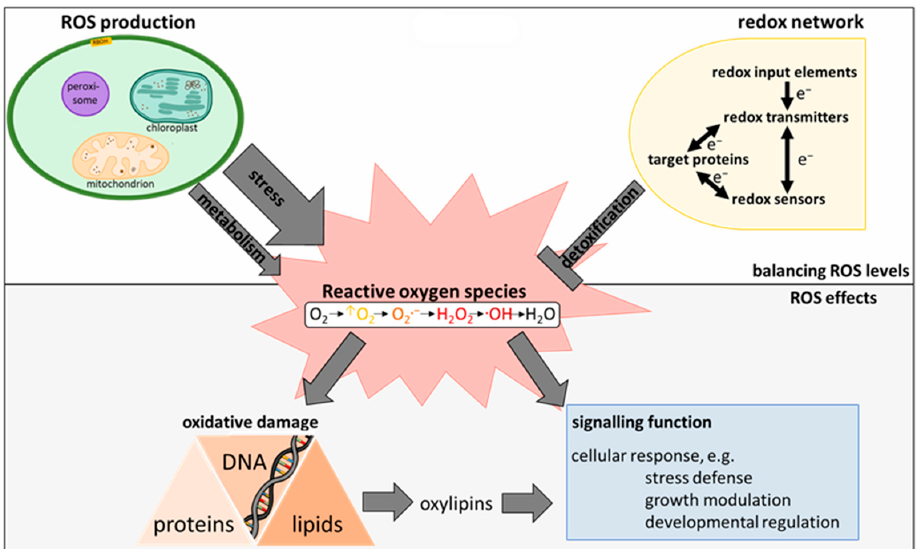
Figure 1 . Regulation of ROS levels and their effect on plant cells. ROS are generated in cytosol, apoplast, plastids, mitochondria, and peroxisomes. ROS generation is strongly stimulated under stress conditions. Contrarily, decomposition of ROS is achieved by enzymatic and non-enzymatic antioxidants under control of the redox-regulatory network. As ROS inflict oxidative damage on proteins, DNA, and lipids (yielding e.g., oxylipins) while also fulfilling signaling functions, tight control of synthesis and degradation of ROS is essential for plant fitness and